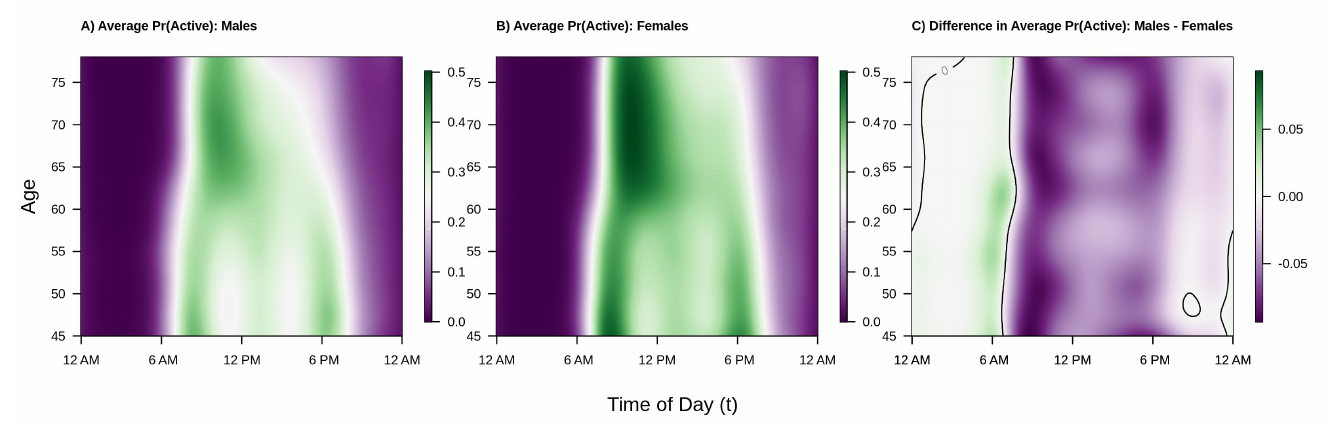
Figure 4. Estimated population average probability of being active (or, more specifically, generating ENMO greater than or equal to 30 milli-gravity units) by age and time of day for Males ( panel A ), Females ( panel B ), and the estimated difference between Males and Females ( panel C ). Color intensity in panels A/B indicates lower (purple) versus higher (green) probability of being active. Color intensity in panel C indicates Males are less (purple), the same (white), or more (green) likely to be active as compared to Females, with a solid black line demarcating the transitions between regions where males are more or less likely to be active than females (i.e., the difference is 0). Estimates of these surfaces in panels A/B are obtained by fitting a generalized function-on-scalar regression (FoSR) model separately by sex where the log odds of being active is allowed to vary smoothly in both time of day and age. The FoSR model is fit by modelling the log odds of being active as a tensor product smooth of marginal spline bases, with cyclic cubic regression splines used in the time domain to respect the cyclic nature of time using binary active/inactive profiles. Panel C is obtained by taking the difference of panels A and